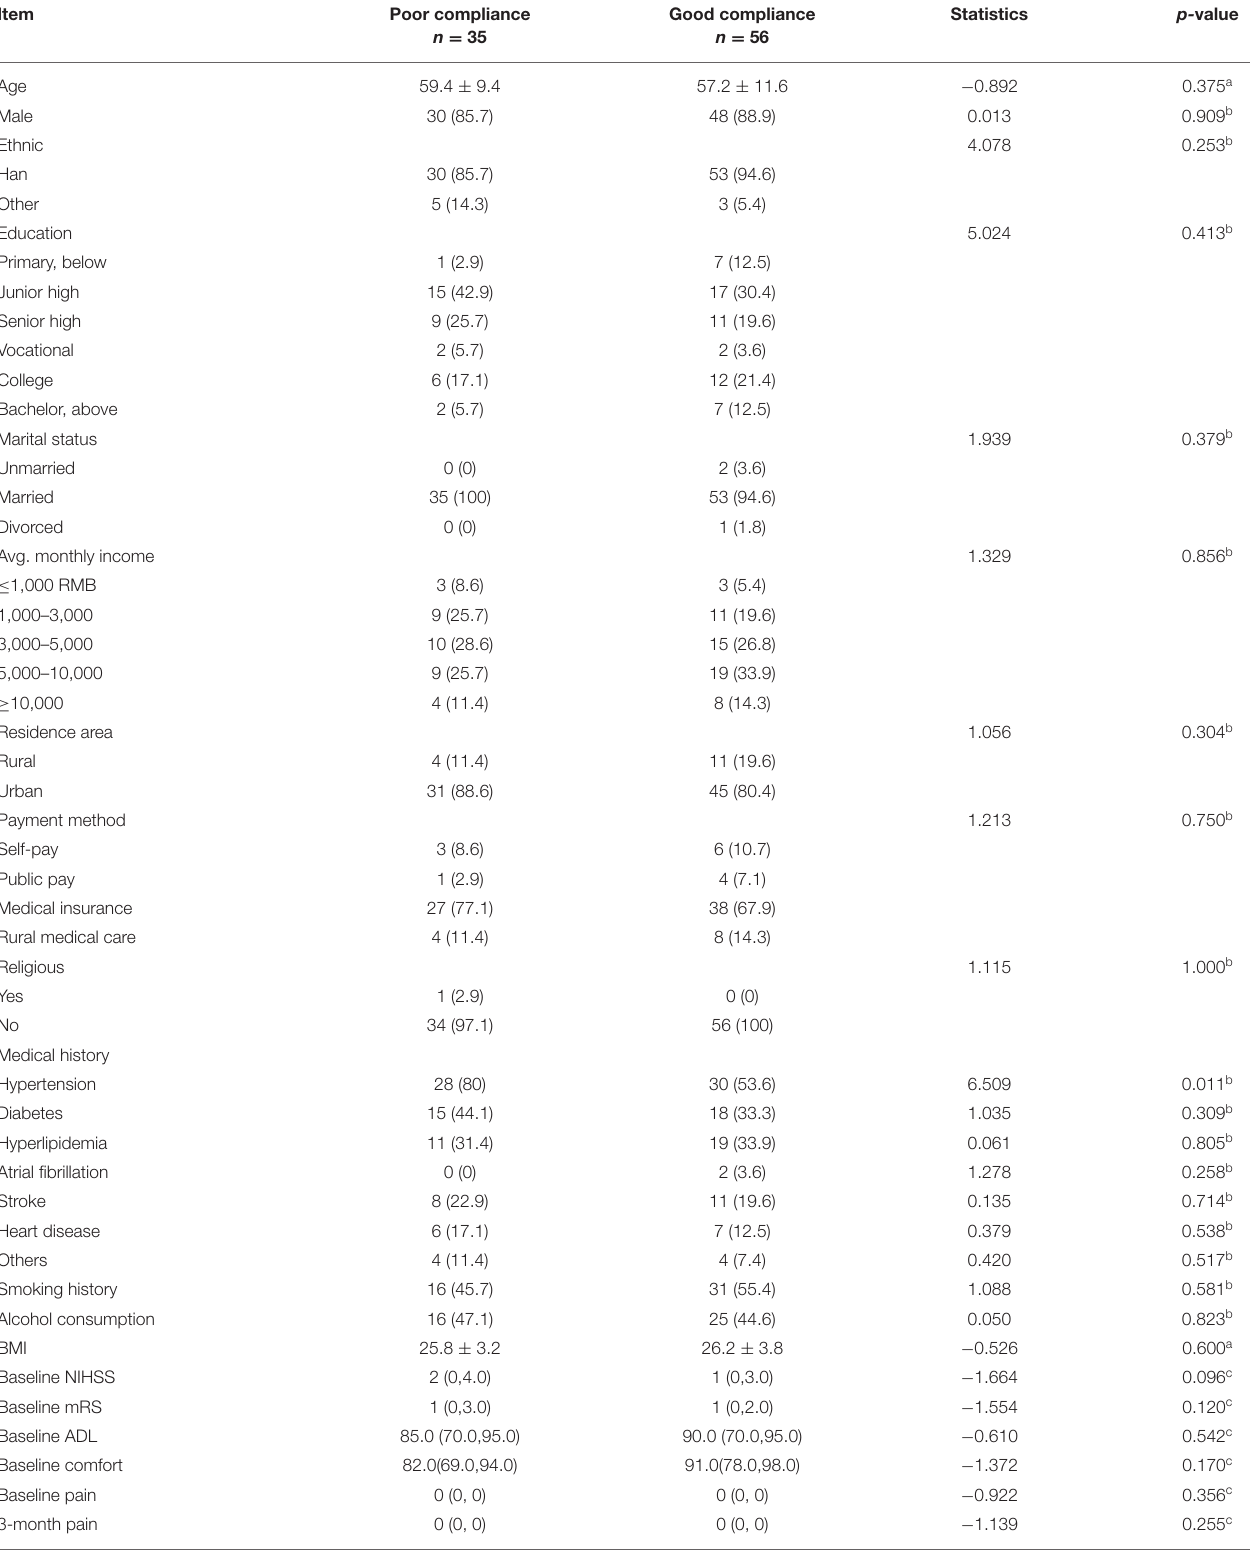
TABLE 1 | Comparison of baseline data between the two